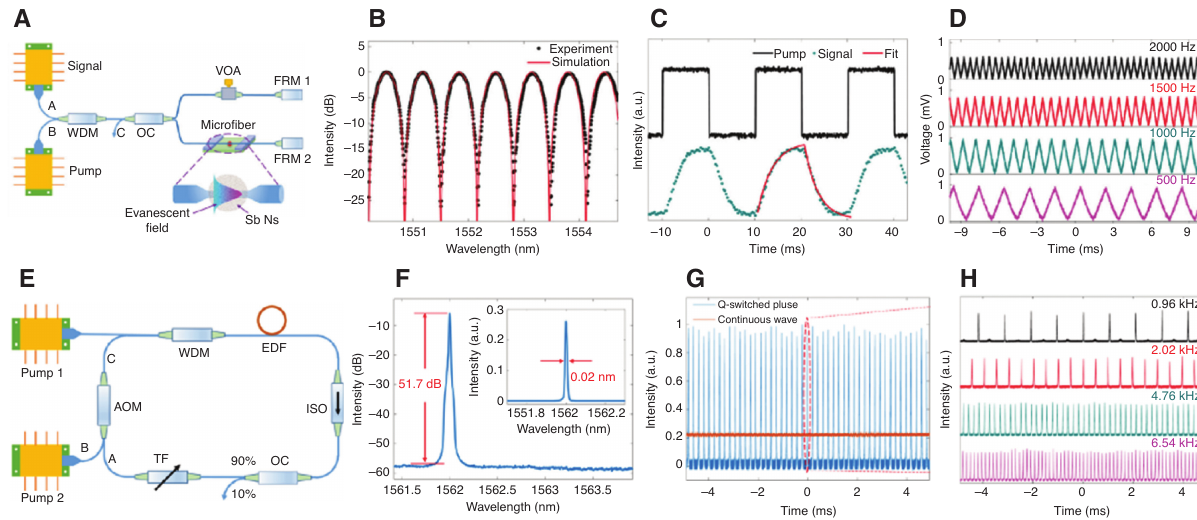
Figure 21: An all-optical, actively Q-switched fiber laser by an antimonene-based optical modulator. (A) Schematic diagram of an acousto-optic modulator (AOM). (B) Measured interferometric spectrum. (C) Intensity modulation. (D) Waveforms at different modulation frequencies. (E) Schematic diagram of actively Q-switched fiber laser by the antimonene nanosheets- based AOM. (F) Measured spectrum at the repetition rate of 4.76 kHz; inset: linear coordinate. (G) Typical pulse trains and continuous wave. (H) Pulse trains at different repetition rates. Reproduced with permission from Ref. [72]. Copyright 2019, John Wiley and